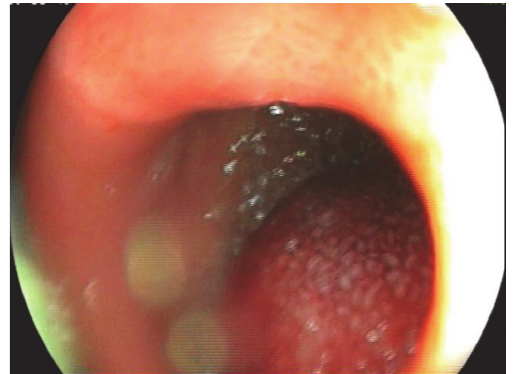
Figure3:Endoscopicultrasonographyrevealedavascularaheteroe- choic submucosal mass at the posterolateral wall of the